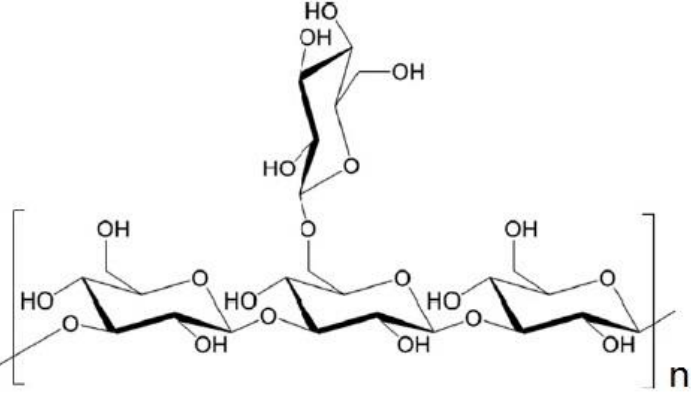
Figure 1. Chemical structure of the biopolymer (Molecular weight, 2–3 × 10 6 g/mol).